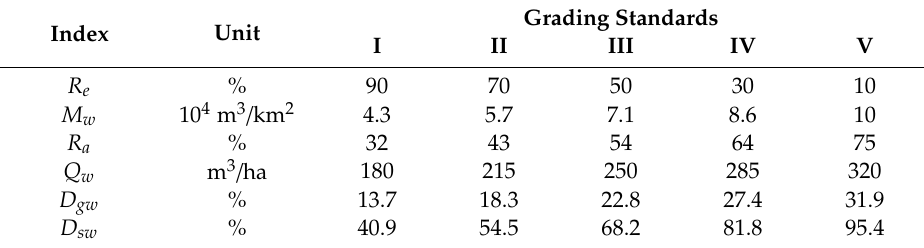
Table 2. The evaluation system and grading standard of agricultural water resource carrying